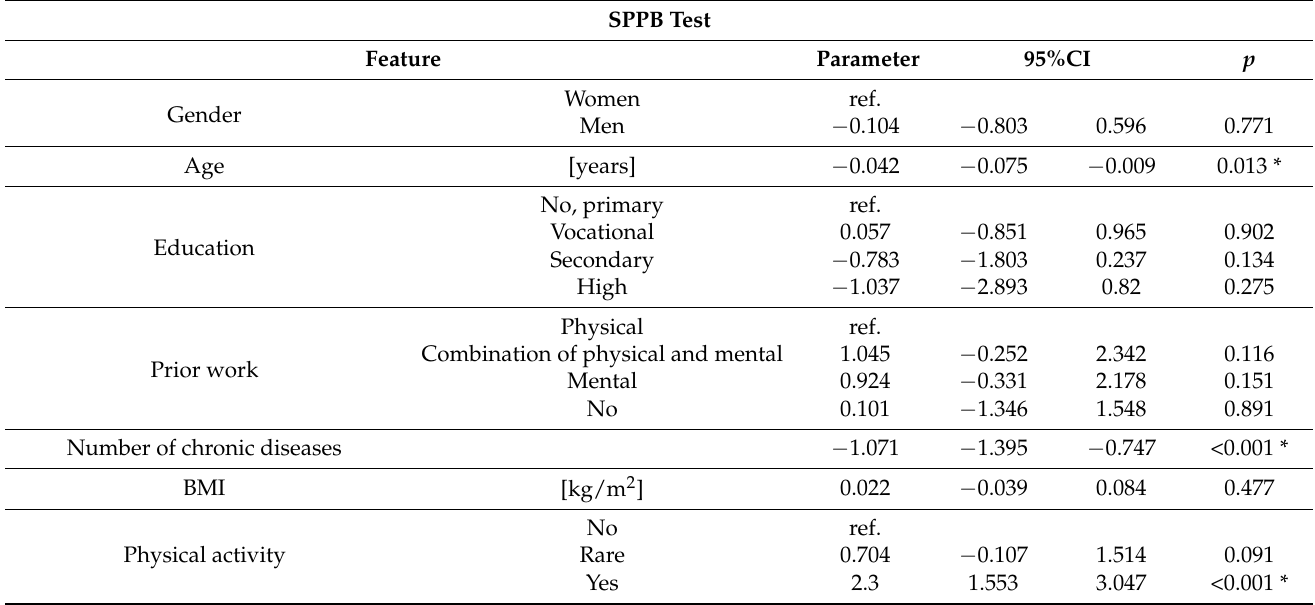
Table 6. Direct predictors of the frailty syndrome–the multifactorial